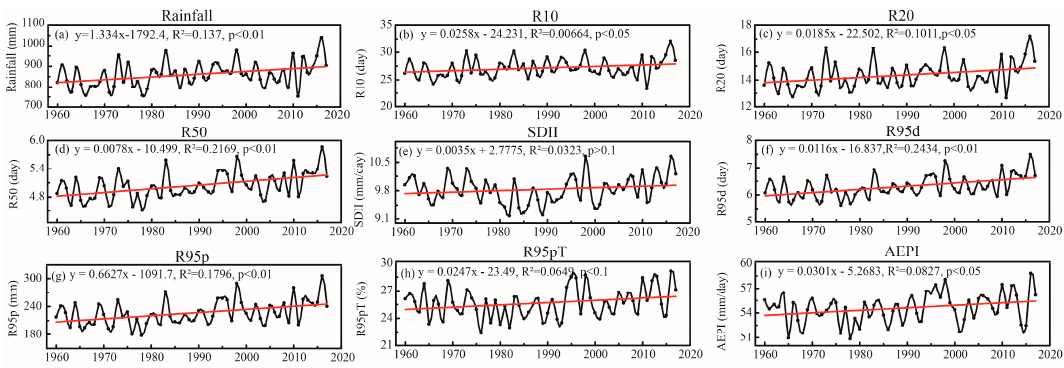
NW were 5.25%, 3.63%, and 0.27% respectively. The trends of R95d, R95p, R95pT, and AEPI in the